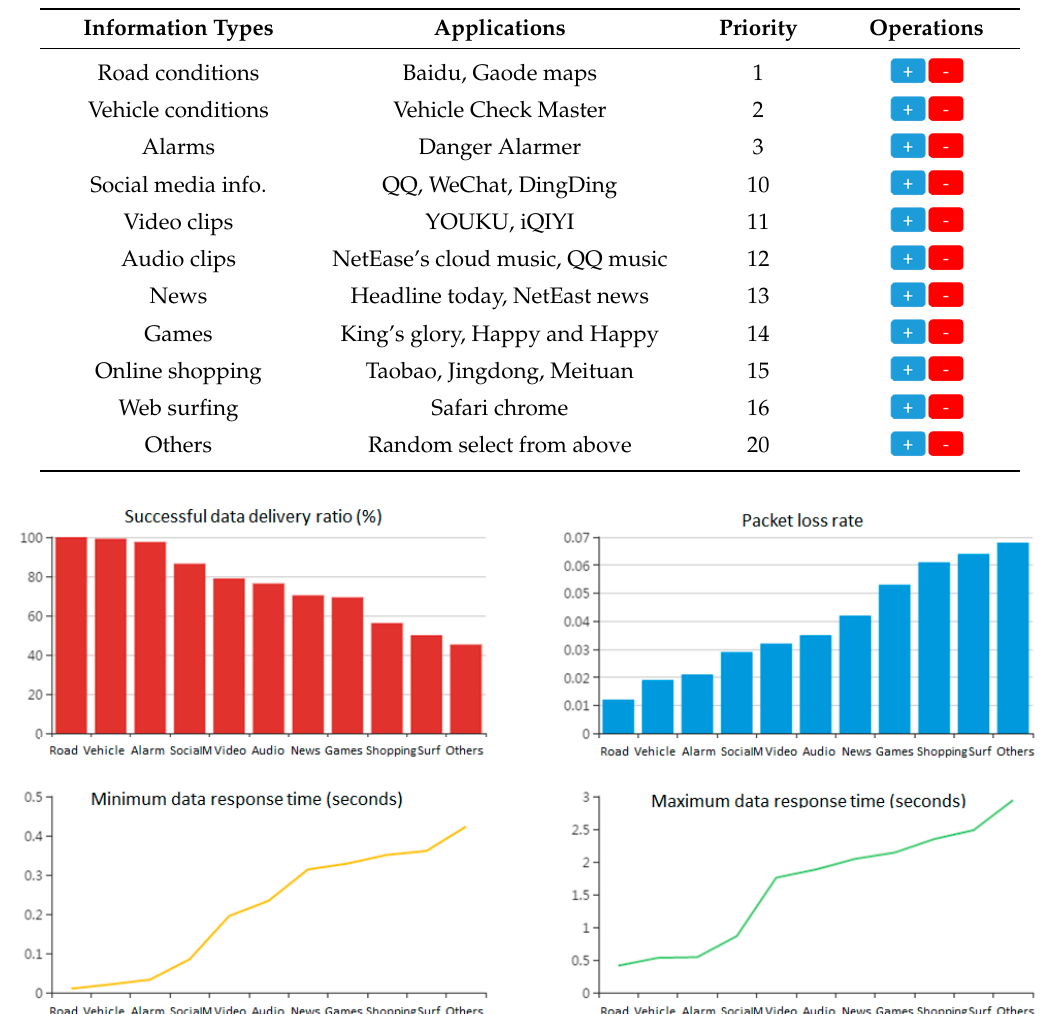
Figure 20. Performance of delivery of different types of messages.